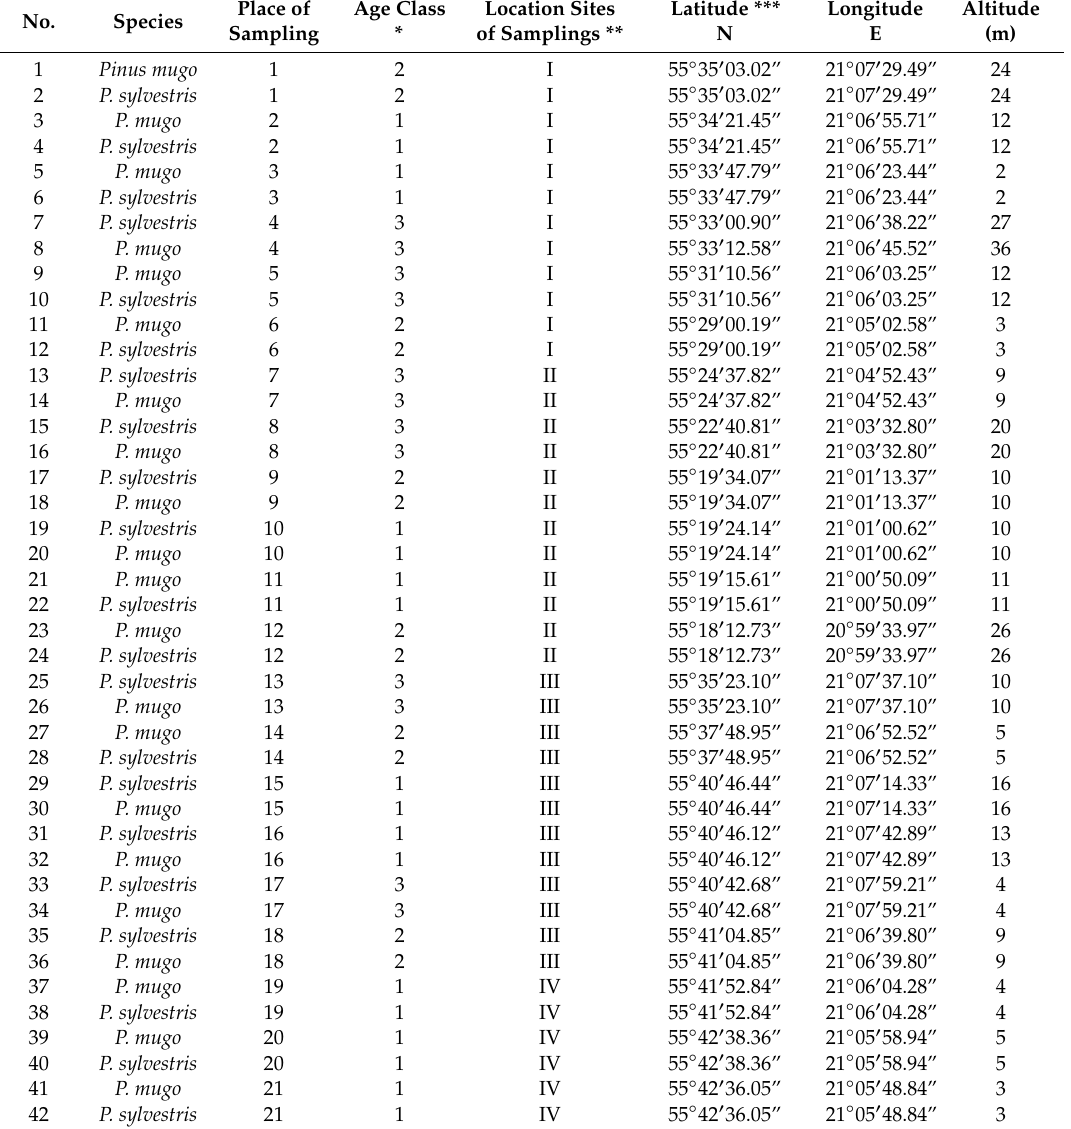
Table A1. Location of sampling sites on the Curonian Spit,